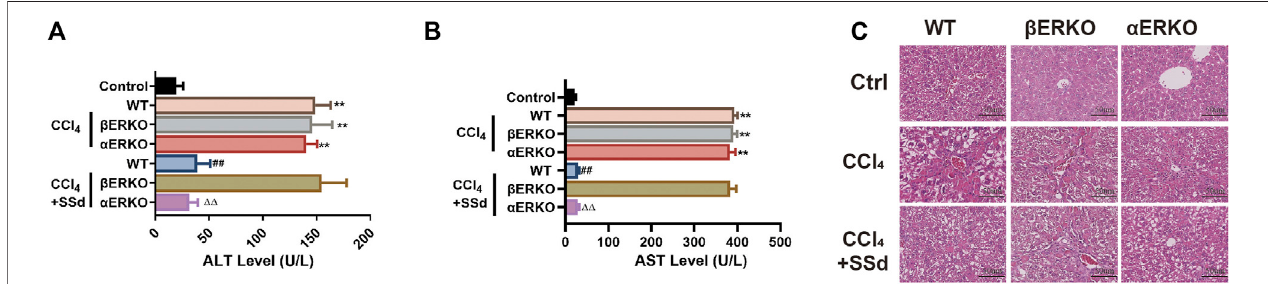
FIGURE5| De fi ciencyofER β ,butnotER α ,blockedtheinhibitoryeffectofSSdagainstCCL 4 -inducedliverinjury (A,B) plasmaALTandASTlevelsweretestedafter CCl 4 treatmentinWTandERKOmicetreatedwithSSdorwithoutSSd, n =6. (C) liverinjurywasdetectedbyHE(×200;scalebar:50 μ m).Dataareexpressedinmean± SEM; ** p < 0.01, CCl 4 treated versus control in WT and ERKO mice; ## p < 0.01, SSd + CCl 4 group versus CCl 4 group in WT mice; ΔΔ P < 0.01, SSd + CCl 4 group versus CCl 4 group in α ERKO